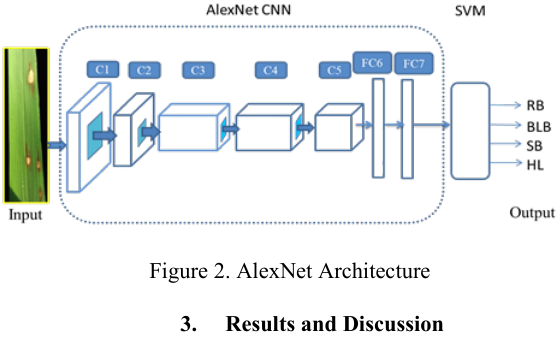
Figure 2. AlexNet